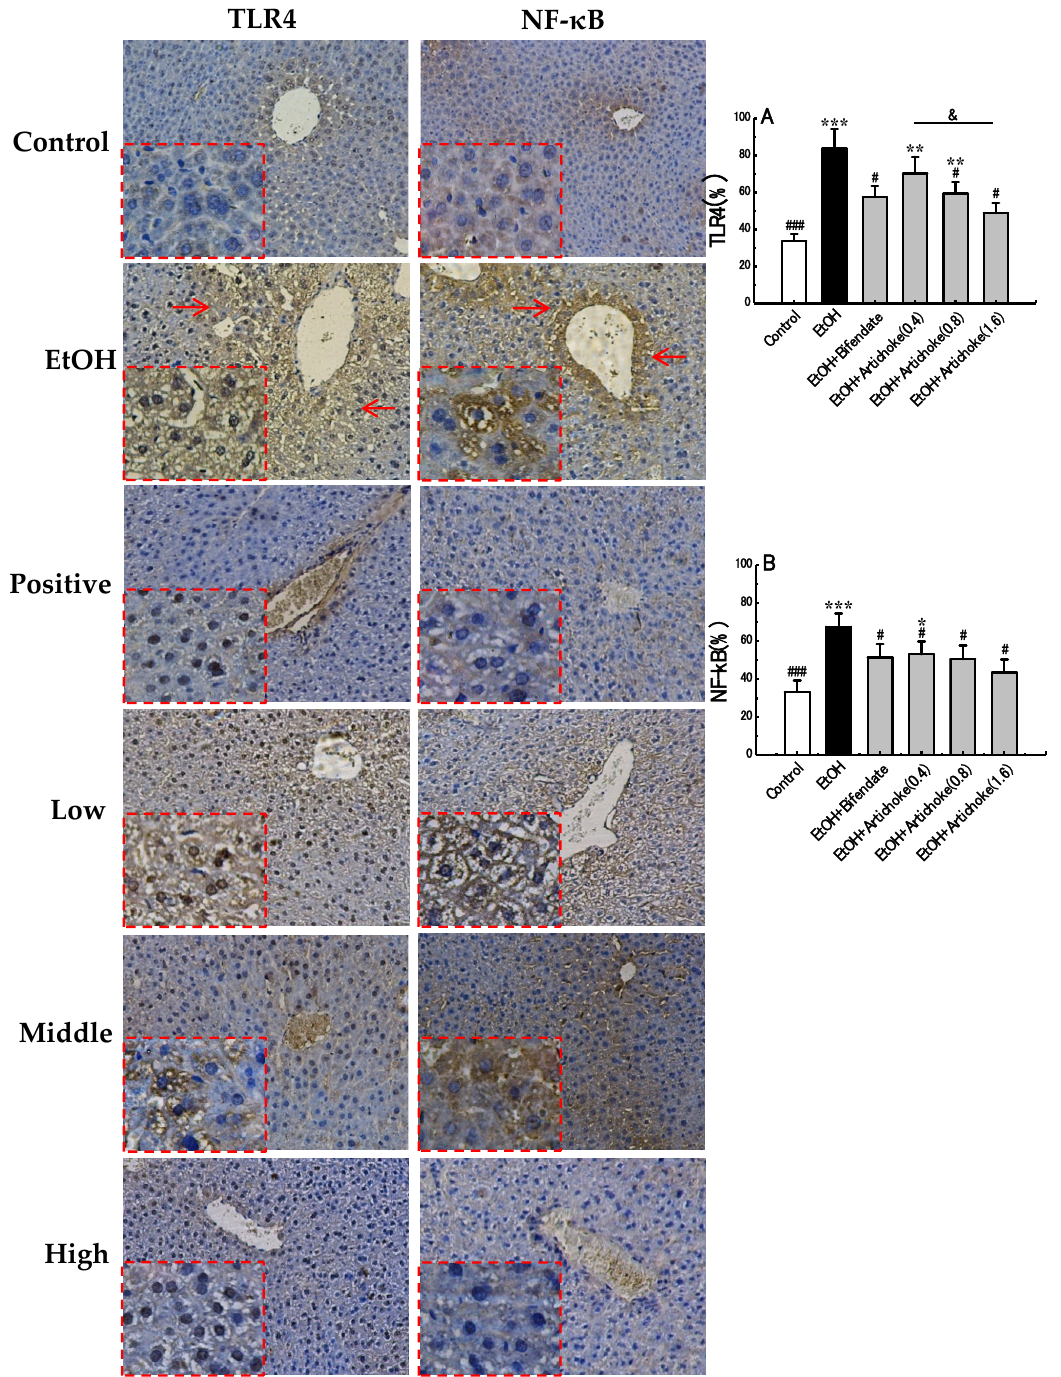
Figure 4. Immunohistochemical analysed results of mice liver in TLR4 and NF ‐κ B. ( A ) mean IOD of TLR4, ( B ) mean IOD of NF ‐κ B, and ( Red Arrows ) positive cells. Original magnification, 200×. * p < 0.05, ** p < 0.01, *** p < 0.001 vs. the control group; # p < 0.05, ### p < 0.001 vs. the EtOH group; & p < 0.05. TLR: toll-like receptor; NF- κ B: nuclear factor-kappa B; IOD: integrated optical